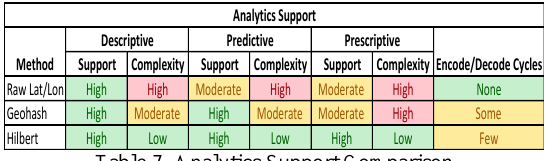
Table 7. Analytics Support Comparison